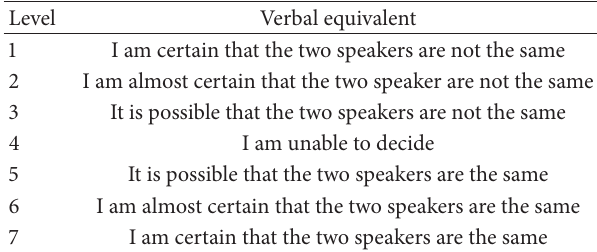
Table 1: The verbal scales used in aural speaker